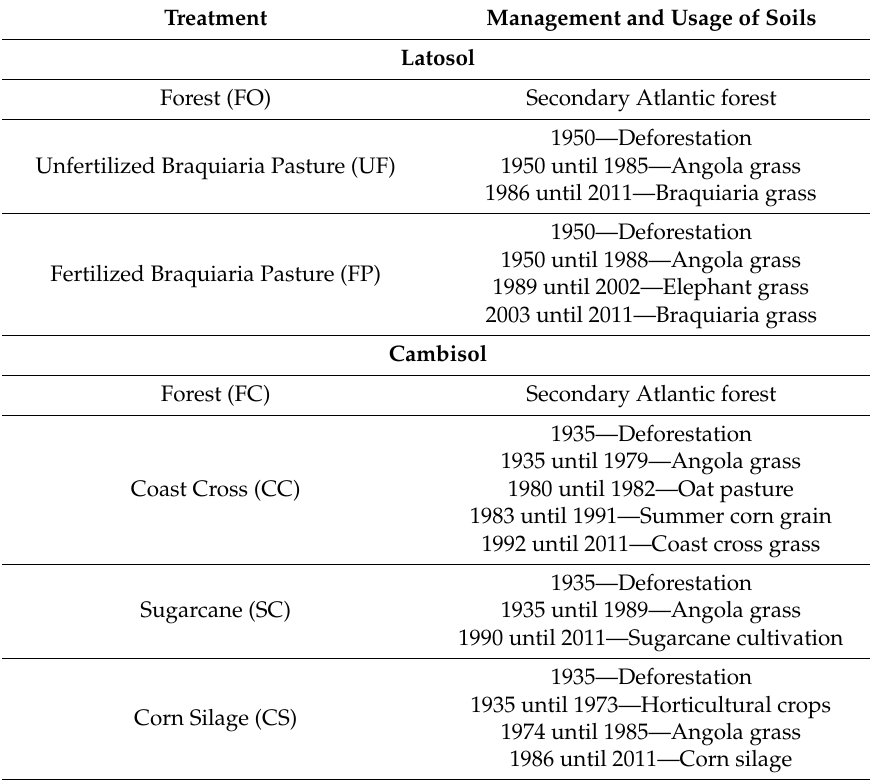
Table 1. Management history and usages for experimental treatments established within upper slope latosol and riverbed alluvial cambisol in the forest zone (Coronel Pacheco,